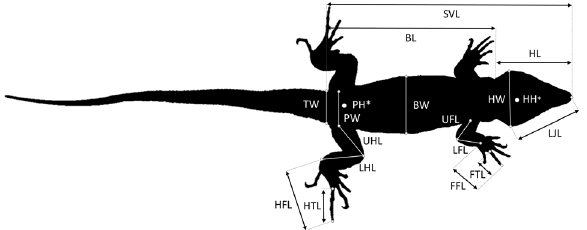
Figure 2. Set of morphological measurements used for the Gran Canaria giant lizard ( Gallotia stehlini ), the Gran Canaria skink ( Chalcides sexlineatus ) and Boettger’s wall gecko ( Tarentola boettgeri ). Snout-vent length (SVL), from the tip of the snout to the posterior tip of the anal scale; head length (HL), from the tip of the snout to the posterior part of the parietal scales; head width (HW), widest point of the head at the level of the jugal bones; head height (HH), highest part of the head, posterior to the orbits; lower jaw length (LJL), from the tip of the lower jaw to the back of the retroarticular process; longest fore toe length (FTL), from the base of the longest toe to the base of the claw; forefoot length (FFL), from the proximal end of the metacarpus to the distal end of the longest toe; lower forelimb length (LFL), from the elbow to the proximal end of the metacarpus; upper forelimb length (UFL), from the insertion of foreleg into body to the elbow; longest hind toe length (HTL), from the base of the longest toe to the base of the claw; hind foot length (HFL), from the proximal end of the metacarpus to the distal end of the longest toe; lower hind limb length (LHL), from the knee to the proximal end of the foot; upper hind limb length (UHL), from the insertion to the body to the knee; pelvis height (PH), height of the body immediately anterior to the hind legs; pelvis width (PW), width of the body immediately anterior to hind legs; tail width (TW), widest portion of the tail; body width (BW), widest portion of mid-body; body length (BL), from the shoulders to the pelvis; LJL was taken only for G. stehlini— due to the difficulty in obtaining precise measurements for this trait in C. sexlineatus and T. boettgeri —whereas UFL, FFL, UHL, HFL, PH, PW, TW, BW and BL were only noted for C. sexlineatus , as these traits are related to burrowing capacity in skinks 23